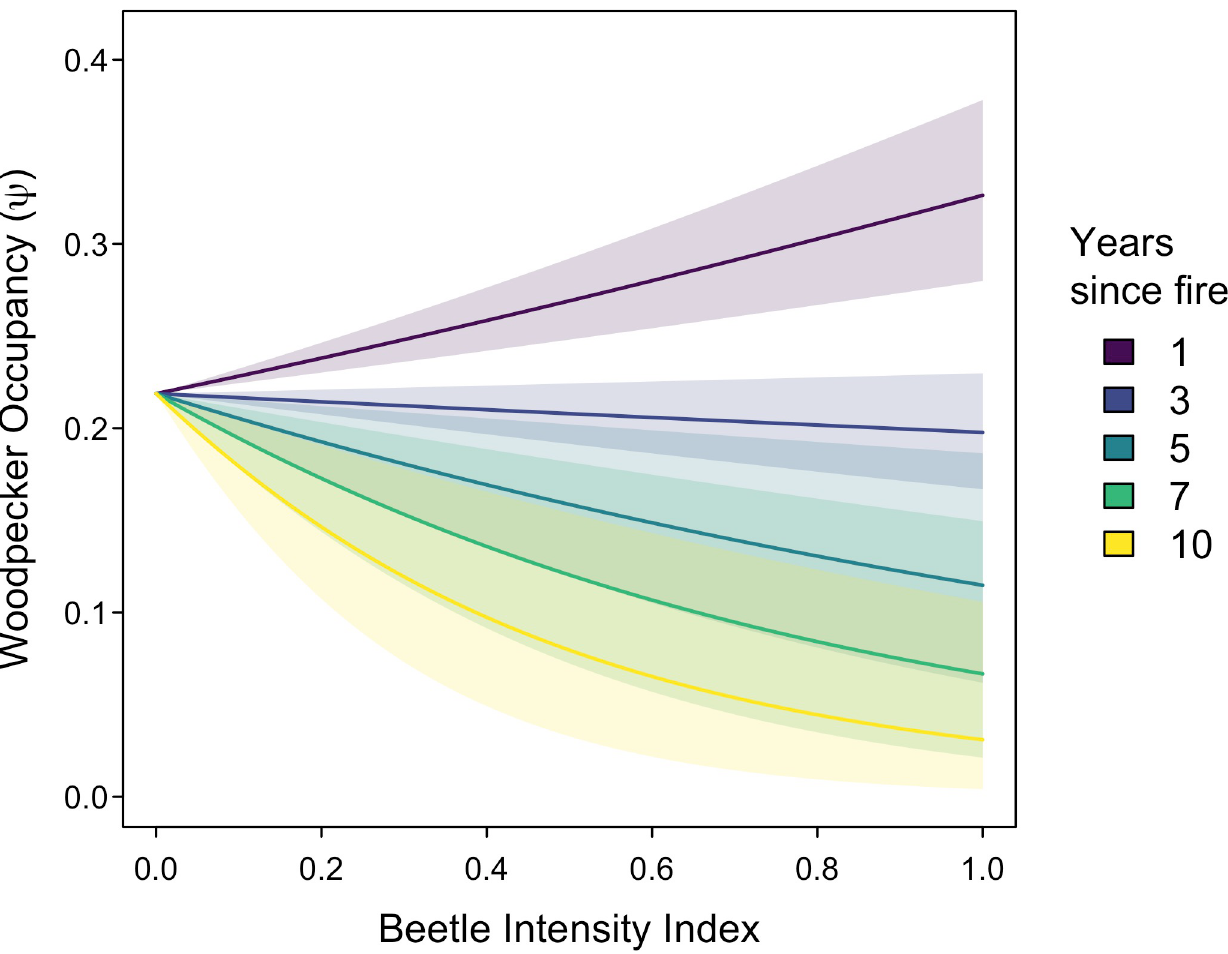
Fig 2. Black-backed woodpecker occupancy as a function of an index of intensity of woodboring beetle sign. The relationship differs depending on the number of years since fire (only 5 years shown, for clarity). Solid lines represent posterior means and ribbons represent partial 95% credible intervals representing uncertainty only in the interaction between beetle sign and years since